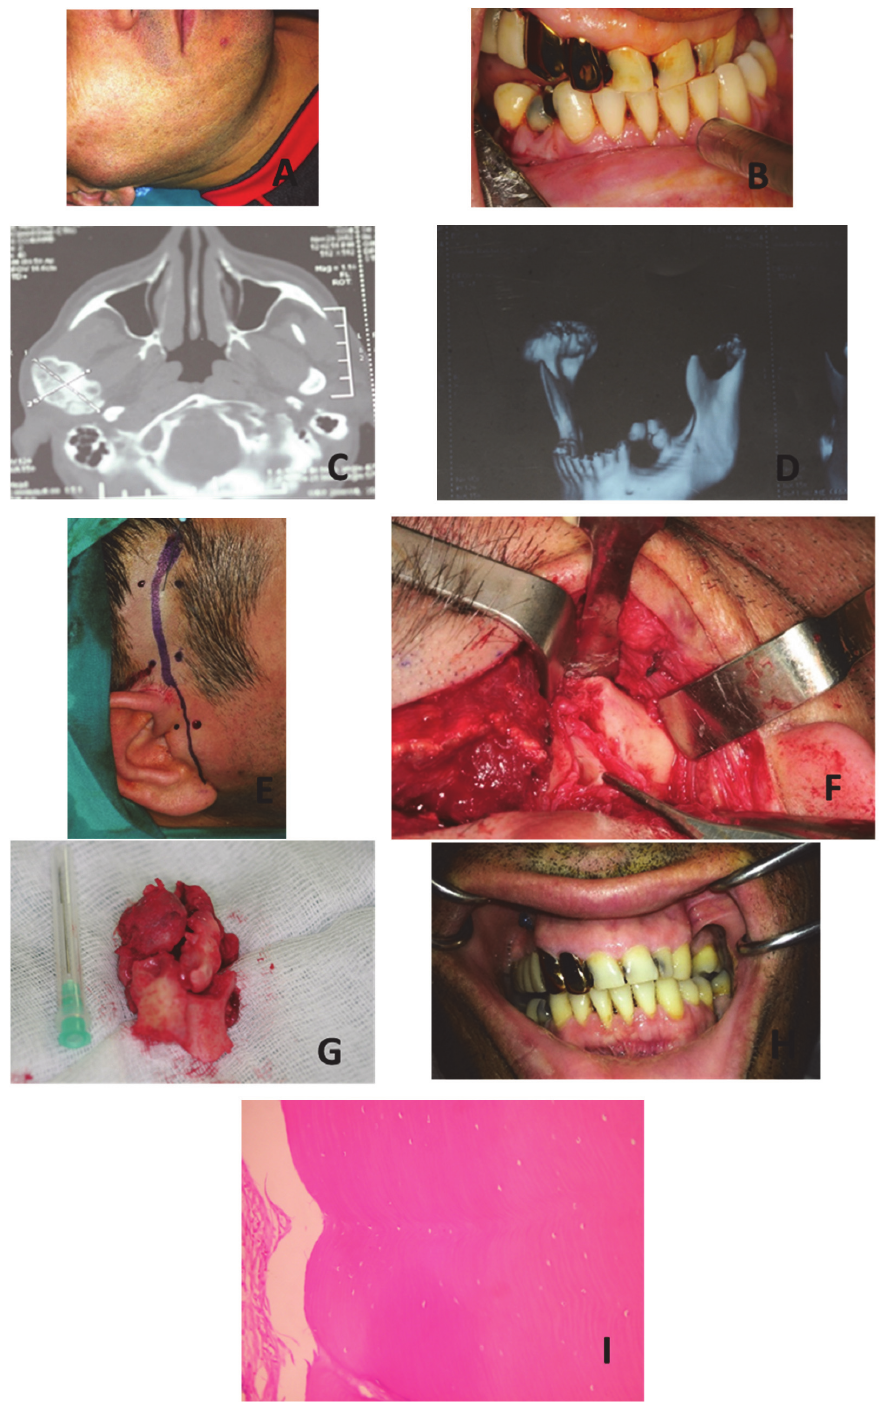
Figure 2. ( A ) Right pre-auricular swelling; ( B ) Posterior open bite on the right and transposition of the mandibular midline on the left; ( C ) Transverse view of CT showing the osteoma of the right mandibular condyle; ( D ) 3D reconstruction of the mandible showing the enlargement of the condyle; ( E ) Pre-auricular incision with temporal extension; ( F ) Exposure of the right mandibular condyle; ( G ) Osteoma after its extirpation; ( H ) The occlusion after removal of the osteoma; ( I ) Compact bone with very sparse arrangement of osteocyte and well-defined borders H & E X200.